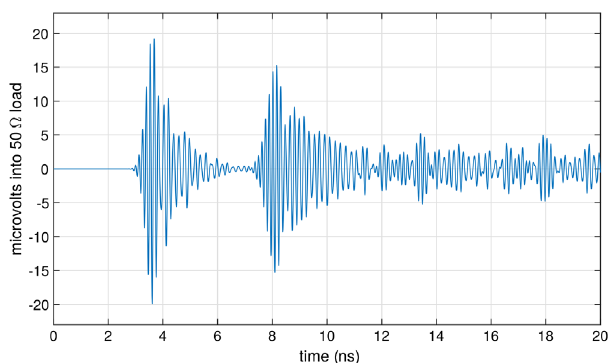
FIG. 6. FDTD simulation of as-built ACE element response to a transverse shower of 100 12.16 GeV electrons, entering after ∼ 4 radiation lengths of tungsten. The distal end of the simulated waveguide has been shorted, producing a reflection, as seen in the measured